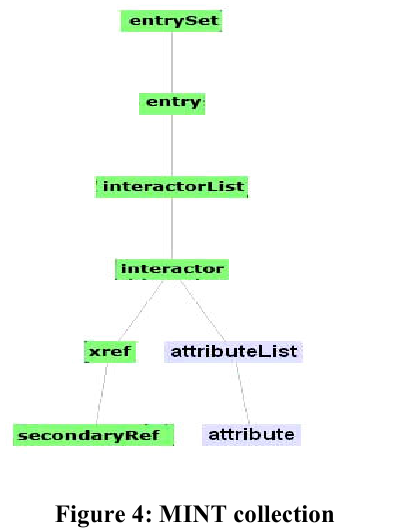
Figure 5: Typical proteinInteractor substructure in summary graph produced by